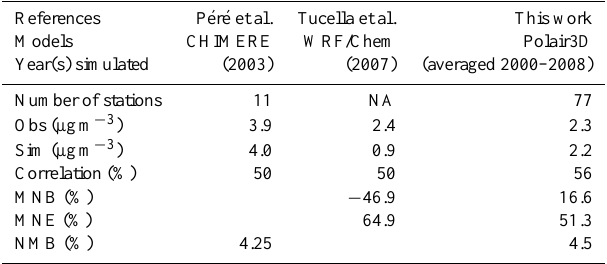
Table B3. Comparison for nitrate with P´er´e et al. (2010) and Tuc- cella et al. (2012). The data from this work are averaged over 2000–